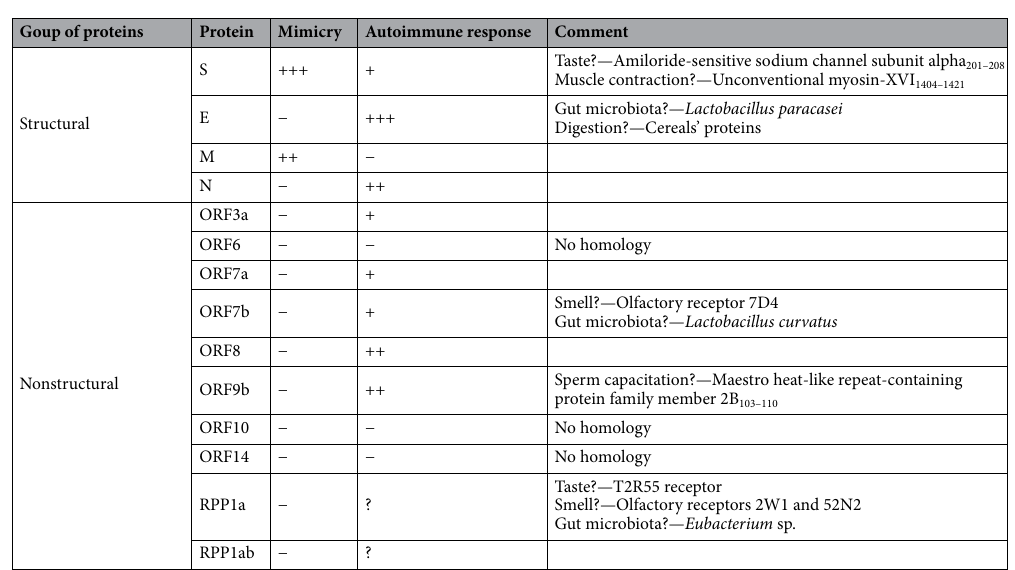
Table 12. Qualitative assessment of the possibility for the SARS CoV-2 proteins to be involved in the processes of mimicry and provoking an autoimmune response.